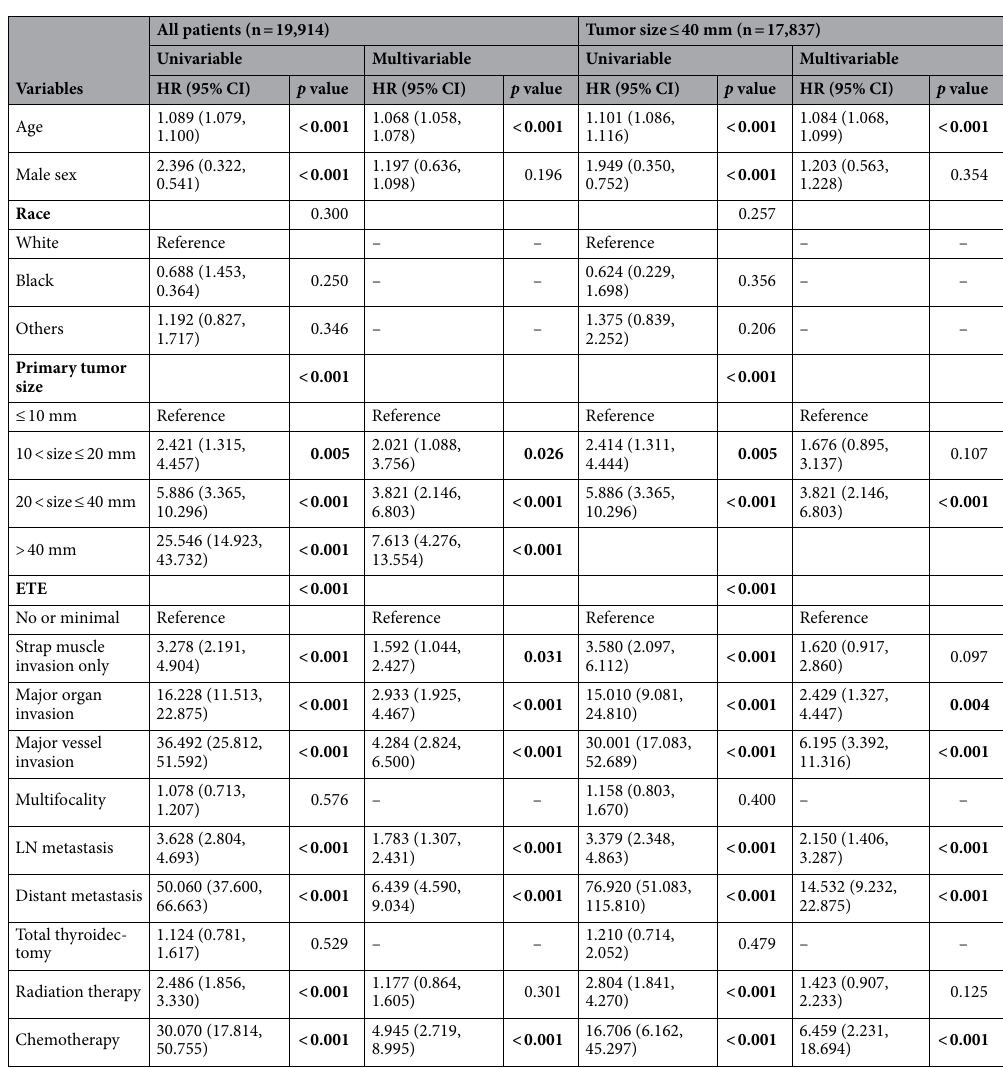
Table 3. Cox proportional hazard analysis for disease-specific survival (DSS) according to the AJCC 8th TNM staging schema. Statistically significant values are shown in bold. DSS disease-specific survival, HR hazards ratio, CI confidence interval, ETE extrathyroidal extension, LN lymph